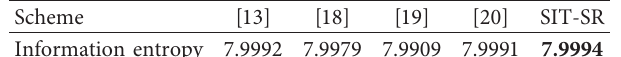
Table 9: Information entropy test results of Lena cipher images. Scheme